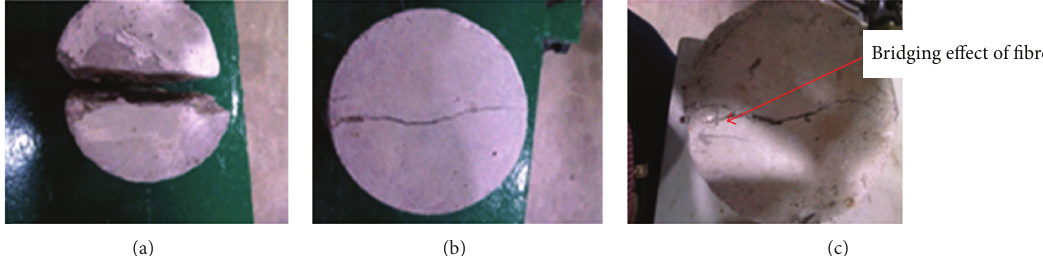
Figure 6: (a) Failure mode of NRC cylinder. (b) Failure mode of HSFRC cylinder. (c) Bridging action of steel fibers in HSFRC cylinder.